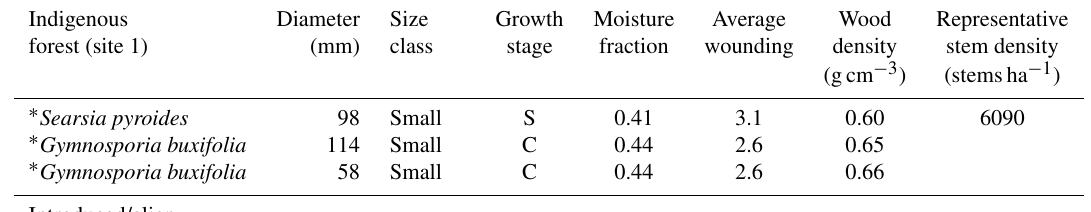
Table 1. Tree physiology and specific data required for the calculation of sap flow and upscaling. Indigenous